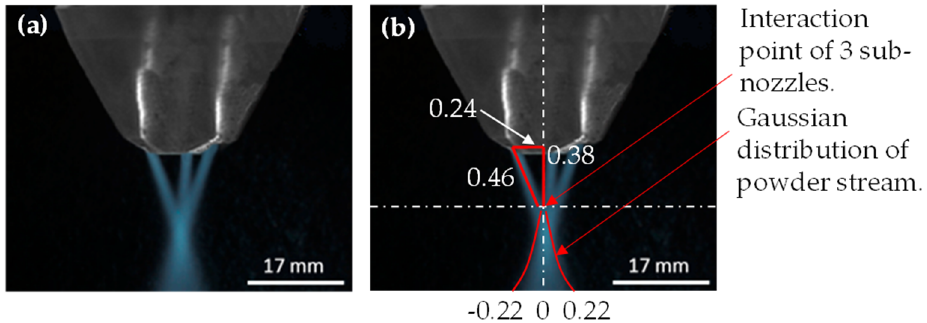
Figure 4. A three-jet powder stream distribution ( a ) experimental image and ( b ) image processed via “Image J” software; all units are in millimeter (mm).